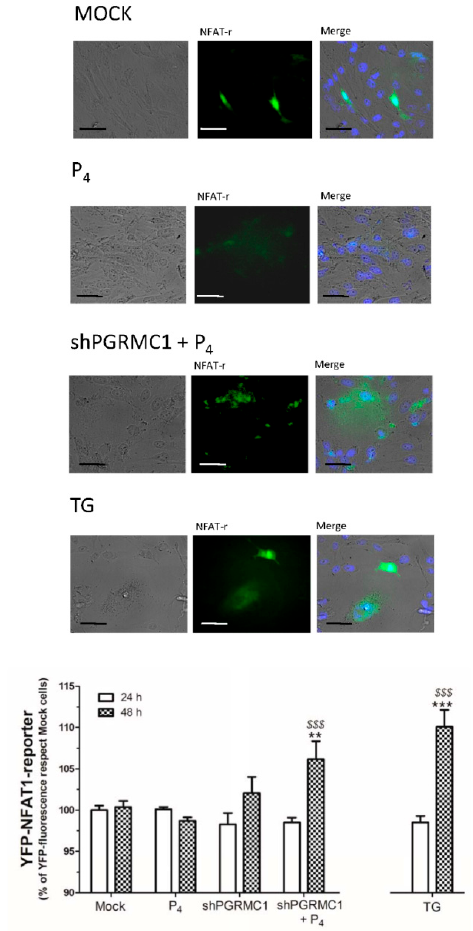
Figure 9. Progesterone receptor membrane component 1 (PGRMC1) silencing enhanced nuclear factor of activated T-cells 1 (NFAT1) translocation to the cell nuclei in MDA-MB-231 cells. MDA-MB-231 cells were transfected for 48 h with yellow fluorescent protein (YFP)-NFAT1-reporter plasmid alone or in combination with the small hairpin siRNA against PGRMC1 (shPGRMC1). Fluorescence of NFAT1-reporter (NFAT-r) was analyzed using cell images of the cultures kept under regular condition or after being incubated with 1 μ M of progesterone (P 4 ) for 24 and 48 h. Images are representative of 3 independent transfections after 48 h of P 4 administration to the respective cell batches. The histogram represents the percentage ± Standard Error of the Mean (S.E.M.) of the NFAT1-reporter fluorescence found in 4–8 images obtained from 3 independent transfections and after normalizing using the fluorescence found in scrambled and P 4 -untreated cells (mock). Internal experimental control consisted of the quantification of NFAT1 translocation due to store-operated Calcium entry (SOCE) evoked by thapsigargin (TG) administration. **, ***: represent p < 0.01 and 0.001 with respect to the scrambled and P 4 -untreated cells; meanwhile, $$$ : represents p < 0.001 with respect to the scrambled cells and cells treated with P 4 , respectively. The bar represents 50 μ m.